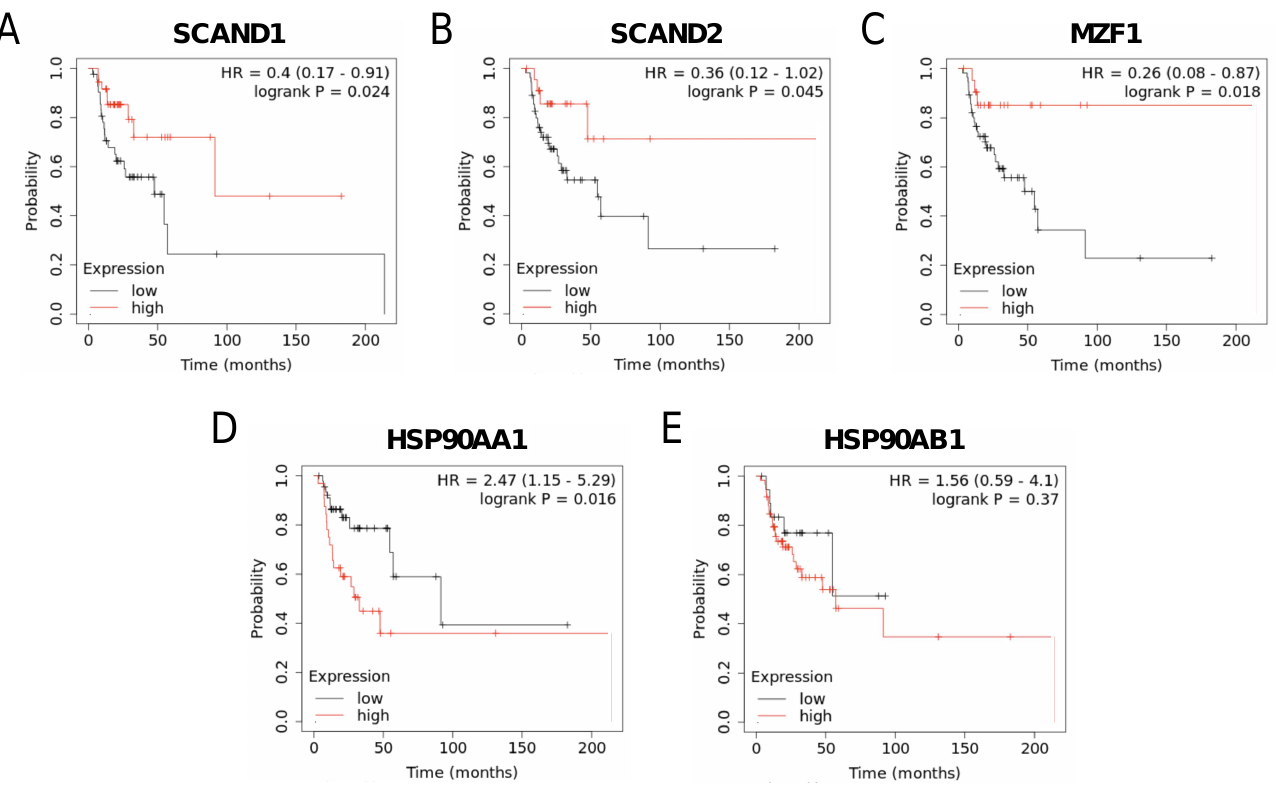
Figure 9. Kaplan–Meier plots showing prognostic values of SCANDs, MZF1, and HSP90 gene expression in head and neck cancers. Data were from TCGA PanCancer Atlas, head and neck squamous cell carcinoma (HNSC) (stage III), n = 78. High expressions of SCANDs and MZF1 ( A – C ) are correlated with better prognosis, whereas high expressions of HSP90 ( D , E ) are correlated with poor prognosis of head and neck SCC. Data in panels A and C were published in: Eguchi, T., et al., 2022